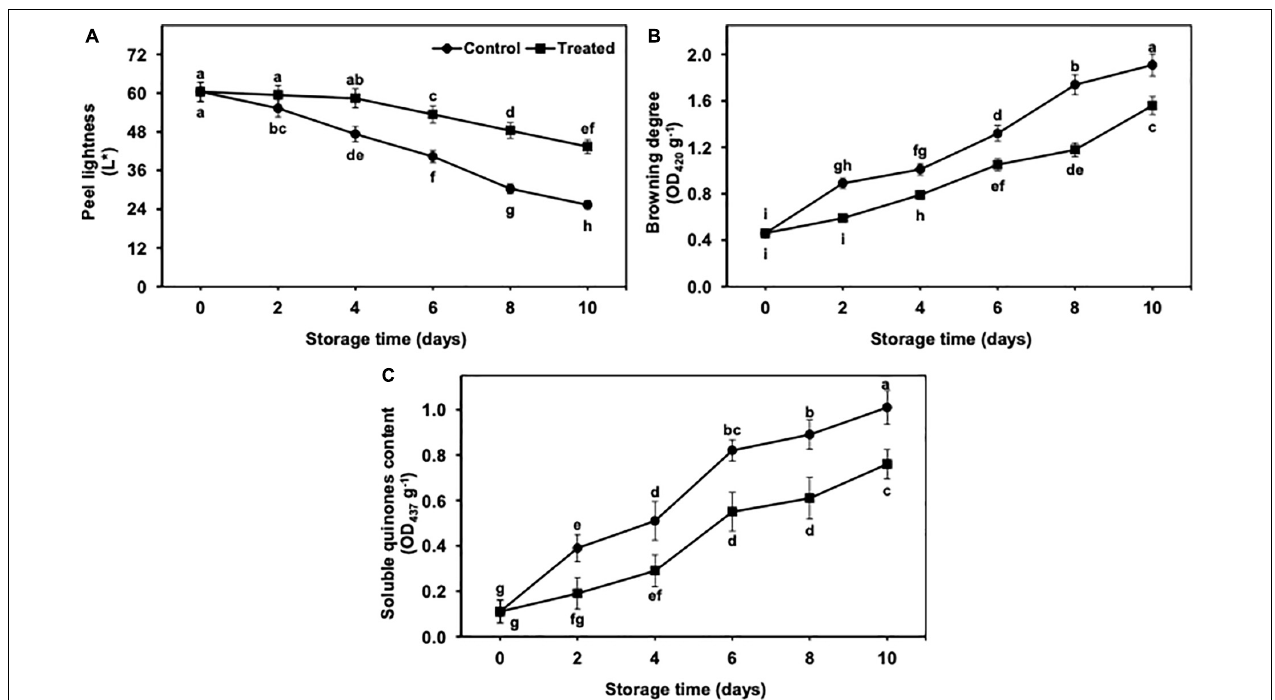
FIGURE 2 | Effect of hydrogen sulfide on peel lightness (A) , browning degree (B) and soluble quinones content (C) in peel of banana fruit. Data are mean of three replications and vertical bars show standard of the means. Different letters show significant difference according to least significant difference